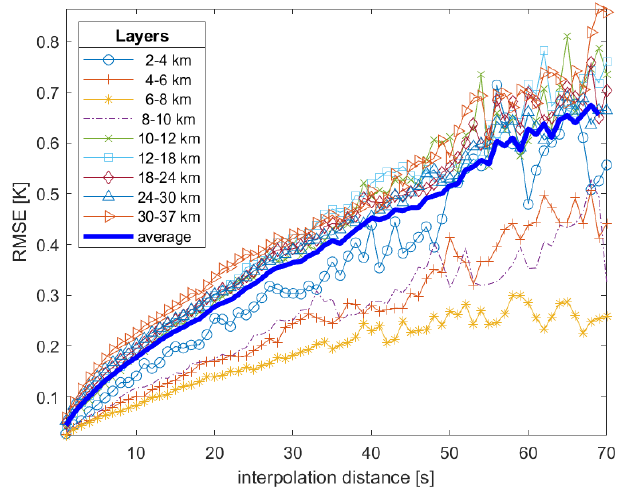
Figure 10. Each line shows the cross-validation RMSE of linear in- terpolation as a function of the interpolation distance (s) for a spe- cific atmospheric layer in the range of 2–37km. The interpolation distance ( x axis) is given by the geometric mean of the distances of all missing data from the closest good data, y − and y + . The graph is obtained my merging the block-bootstrap simulations with average gap sizes µ G = 10 and 30s.